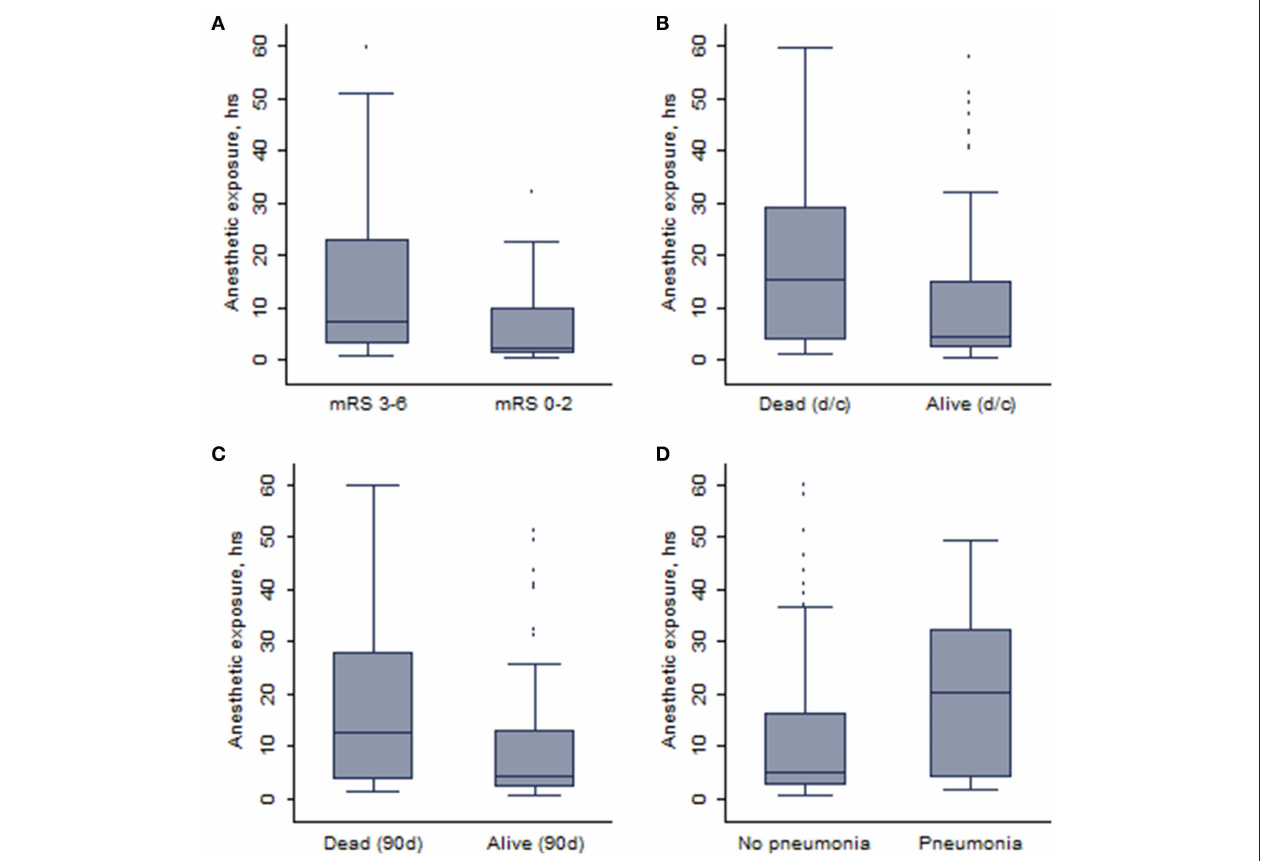
FIGURE 2 | The whisker plots showing the association between duration of anesthetic exposure and (A) 90-days independent functional outcome, (B) survival at discharge (d/c), (C) 90-days survival, and (D) pneumonia.